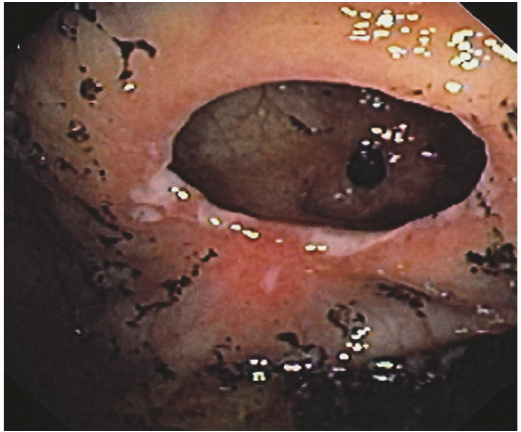
Figure 18: Endoscopic image of cecal diaphragm disease due to nonsteroidal anti-inflammatory